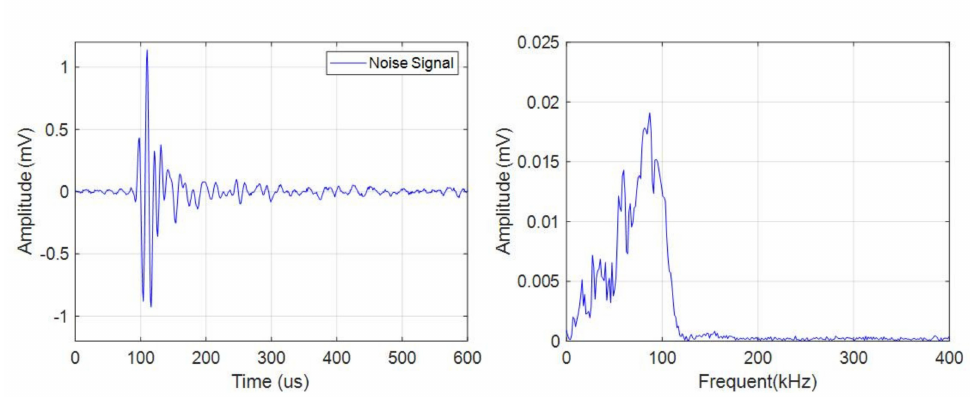
Figure 5. Time domain-frequency domain diagram of pulse type acoustic emission